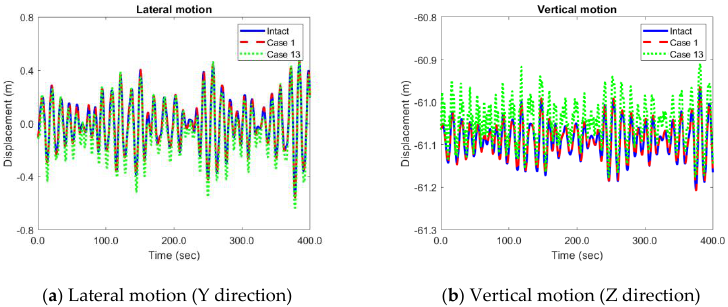
Figure 6. Time histories of lateral and vertical displacements of the tunnel at its mid-length (sensor No. 5) in intact and failure conditions.